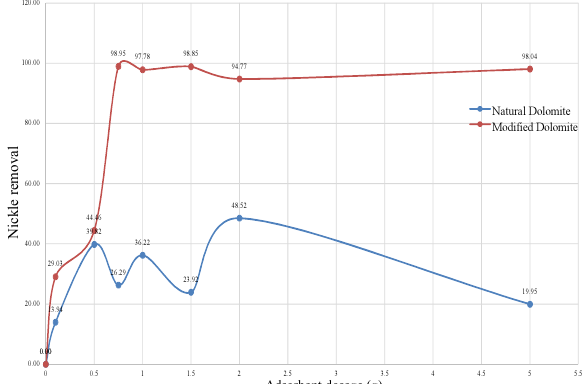
Fig. 9. Comparison of removal rate of nickel from natural dolomite (5 mg/l) and modified dolomite with contact time of 60 minutes in specified adsorbents